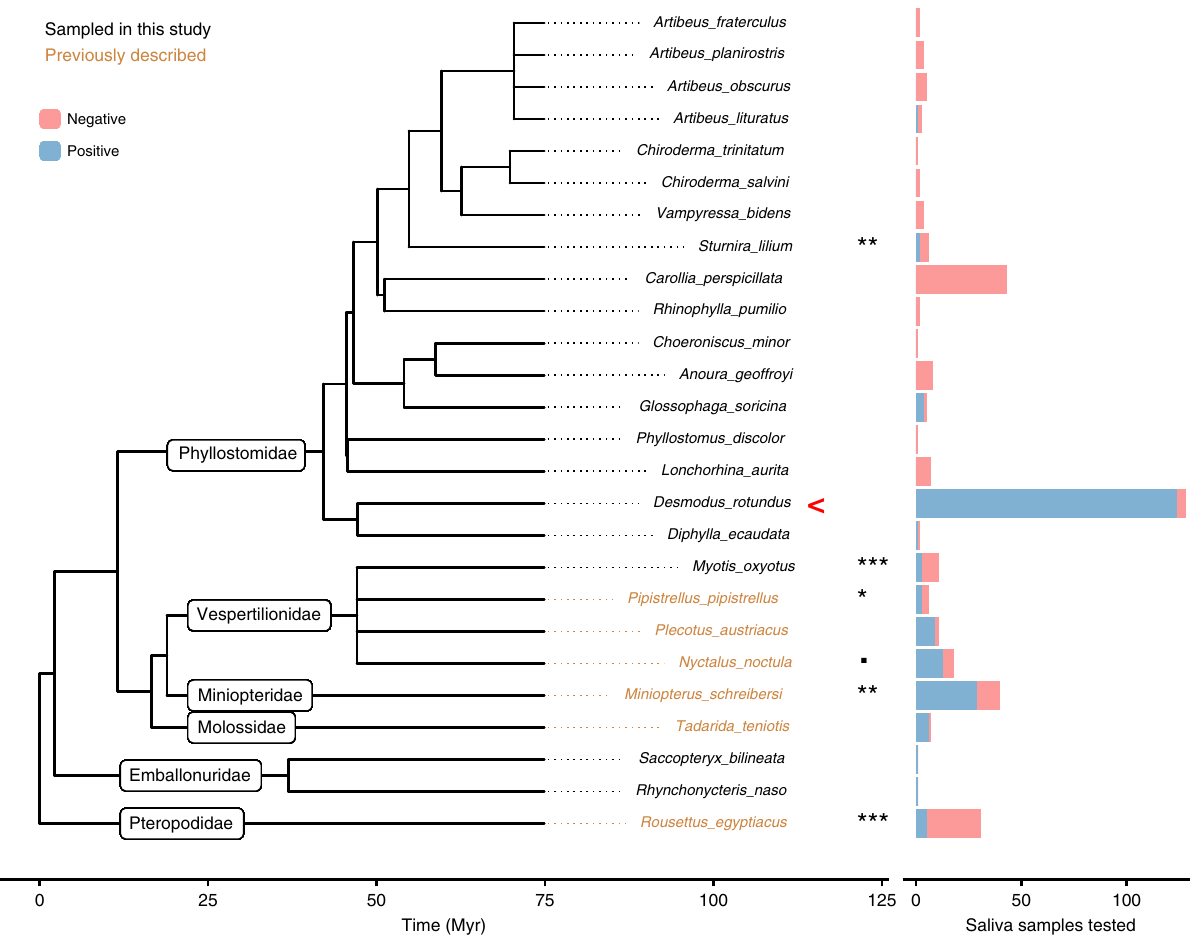
Fig. 1 Widespread BHV infection across the bat phylogeny. The bat phylogeny (left) was extracted from the mammalian super-tree to contain species that were tested here or elsewhere for BHV infection 30,71 . Labels on tree branches indicate bat families. Taxa in black text indicate bat species tested here for the fi rst time. Stacked bar charts (right) indicate the number of saliva samples that tested either positive or negative for BHV by PCR of the terminase gene UL89. A binomial generalised linear mixed model (GLMM) followed by post-hoc pairwise comparisons of estimated prevalence by species (multiple comparisons of means: Tukey contrasts, two tailed) was used to test the signi fi cance of differences in prevalence. The pairwise signi fi cance of prevalence in each species compared to D. rotundus is shown on the bar chart with corrected P -values: > 0.1, * > 0.05, ** > 0.01, *** > 0.005. All other pairwise comparisons were non-signi fi cant. D. rotundus is indicated with a red arrow. Source data are provided as a Source Data fi